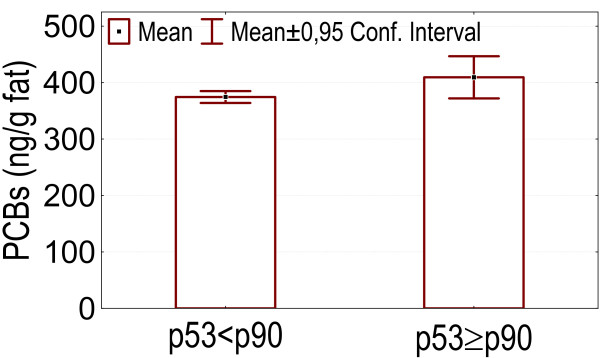
p53 levels above p90: association with higher serum marker PCB concentrations.